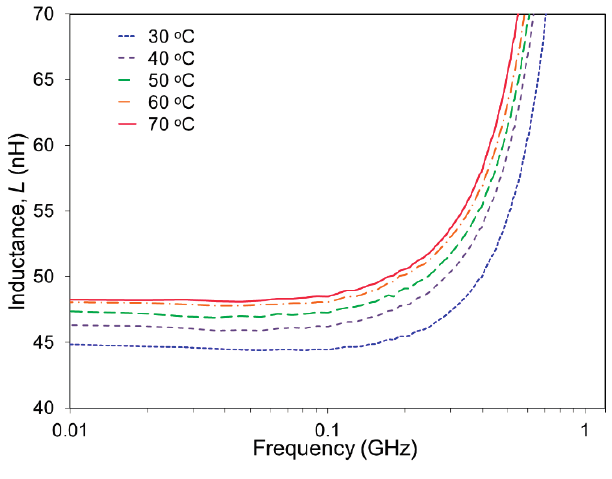
Figure 3. Inductance of the out-of-plane SMA spiral-coil actuator measured as a function of frequency with varying temperatures that determine the height of the coil